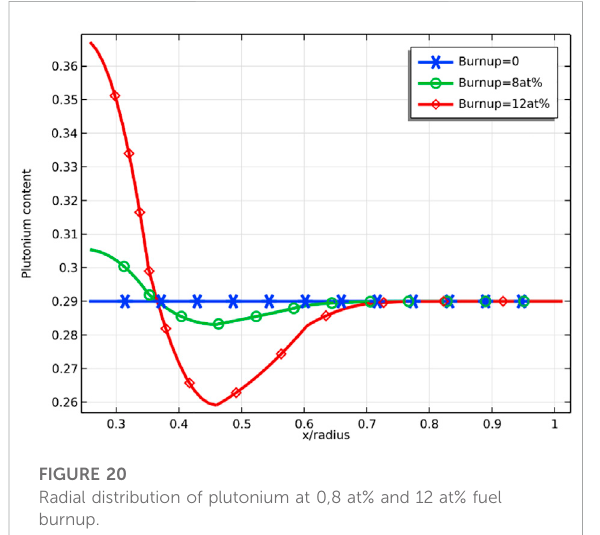
FIGURE 20 Radial distribution of plutonium at 0,8 at% and 12 at% fuel burnup.